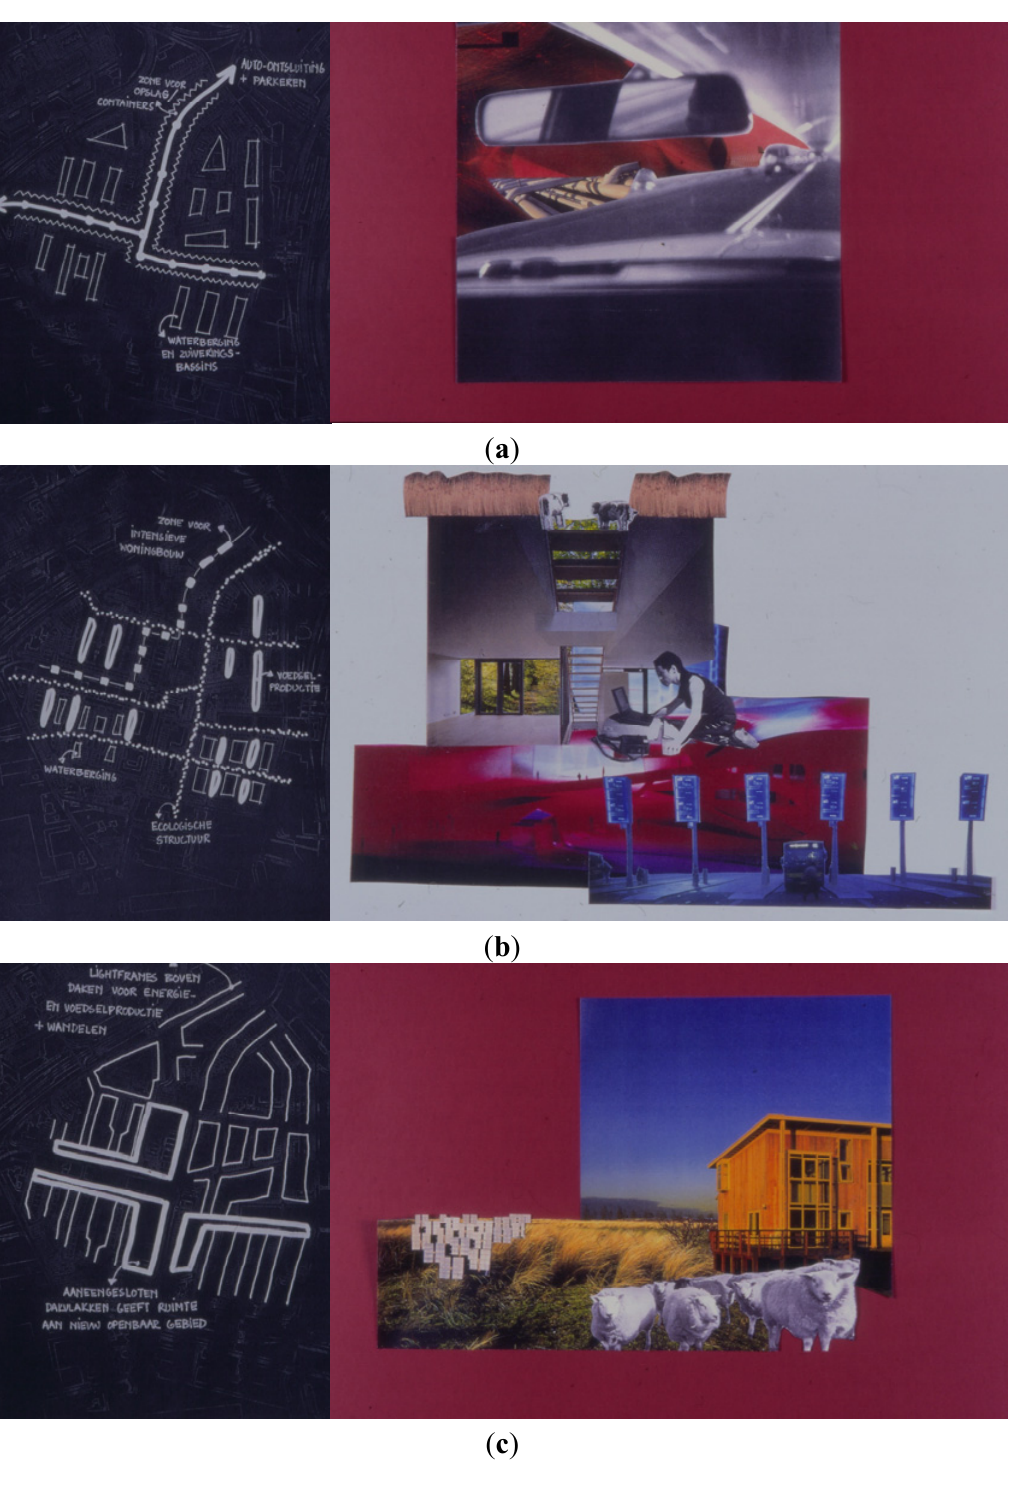
Figure 4. The four layers of the multi-layer city: ( a ) the underground, ( b ) ground level, ( c ) rooftop and ( d )